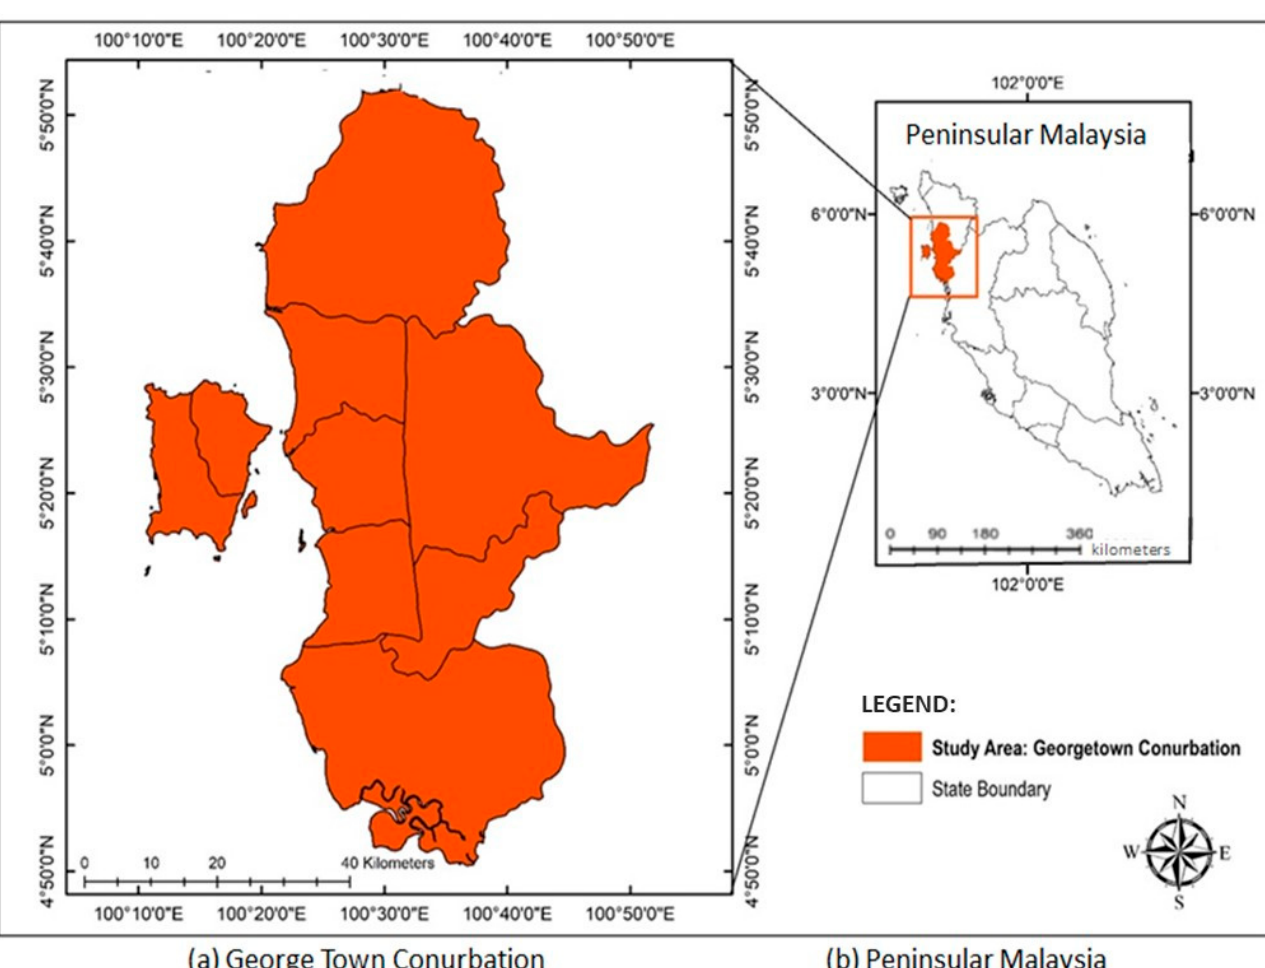
Figure 1. The study area.